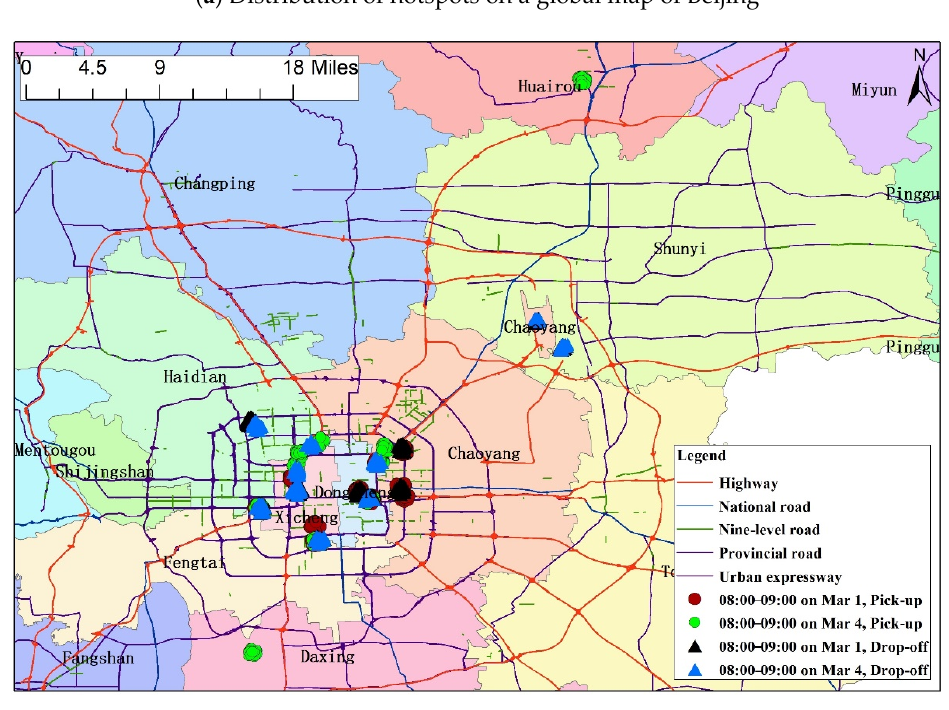
Figure 6. Top 10 hot pick-up and drop-off areas during the same time period on different days. ( a ) shows the distribution of hotspots on a global map of Beijing. ( b ) shows the enlarged view of the area framed by the red box in ( a